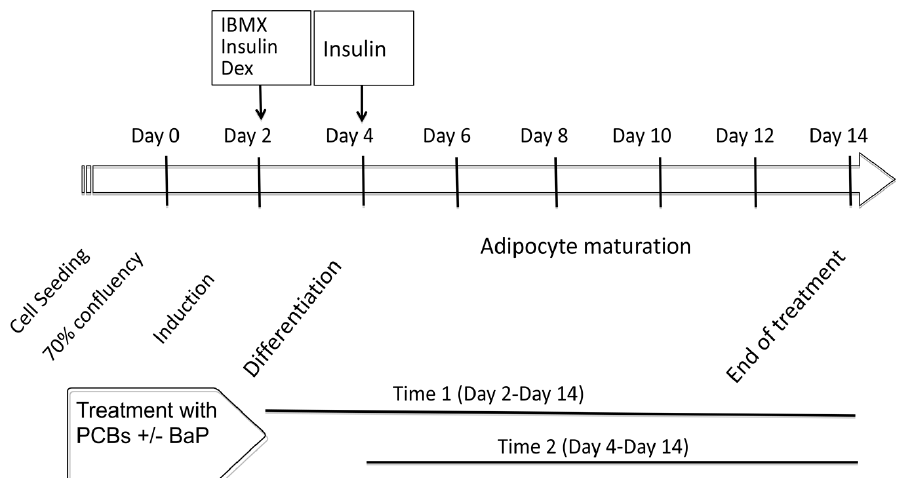
Figure 1. Treatment schedule of 3T3-L1 cells with benzo(a)pyrene (BaP) and/or polychlorinated biphenyls (PCBs) (PCB118 or PCB153) from the induction of differentiation (Time 1: day 2–day 14) or after differentiation (Time 2: day 4–day 14) to the maturation state (day 14). Dex: dexamethasone.